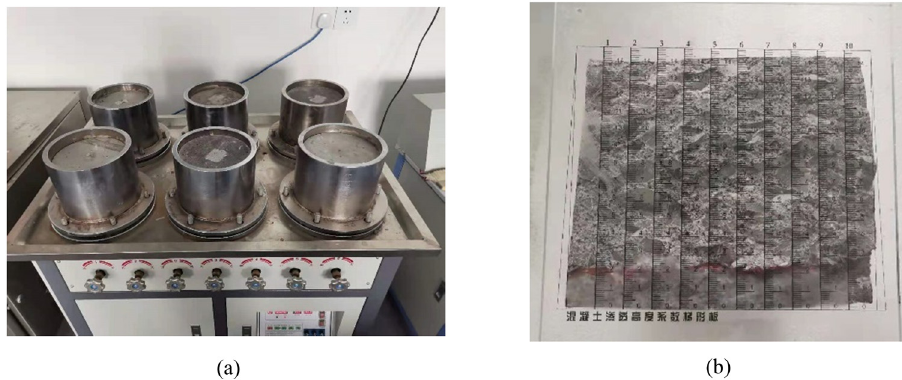
Figure 10: Test on the impermeability of concrete. ( a ) Test instrument for impermeability of concrete. ( b ) Measuring average seepage height of the concrete.